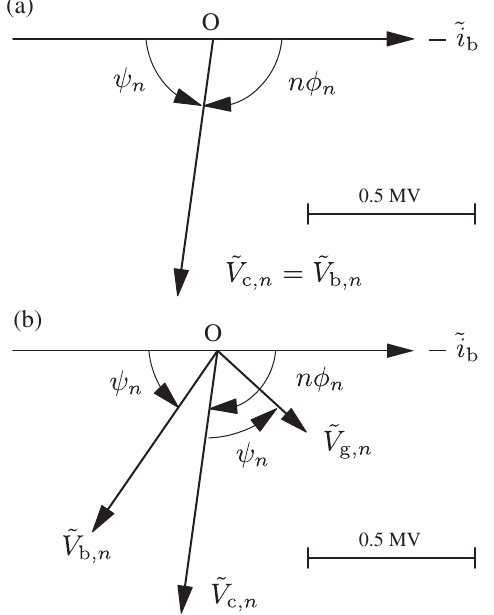
FIG. 2. Typical phasor diagrams showing rf voltages in the harmonic cavities. (a) At a maximum beam current of 500 mA, (b) at a beam current of 100 mA. Assumed parameters are given in Sec. II C. Note that the direction of the beam induced voltage at ~ V ~ i resonance, , is opposite to that of the − br b